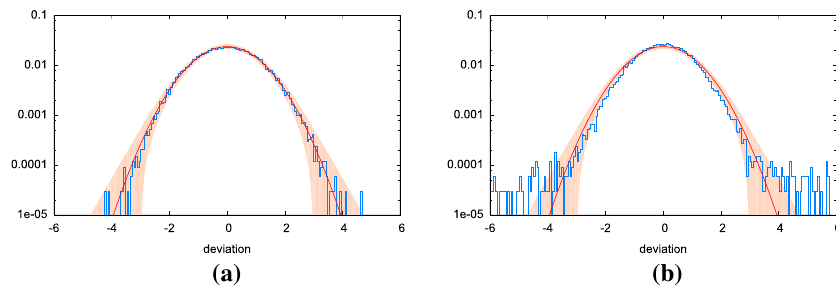
Fig. 74 Histograms of the whitened data samples for the simulated data shown in Fig. 73. A reference N ( 0 , 1 ) Gaussian distribution is shown as a red line . The light red band denotes the 3-sigma confidence interval for the finite number of samples used to produce the histograms. Panel a uses the whitened Fourier coefficients, while panel b uses the whitened time-domain samples. While the non-Gaussianity is most apparent in the time domain, both distributions fail the Anderson–Darling test for